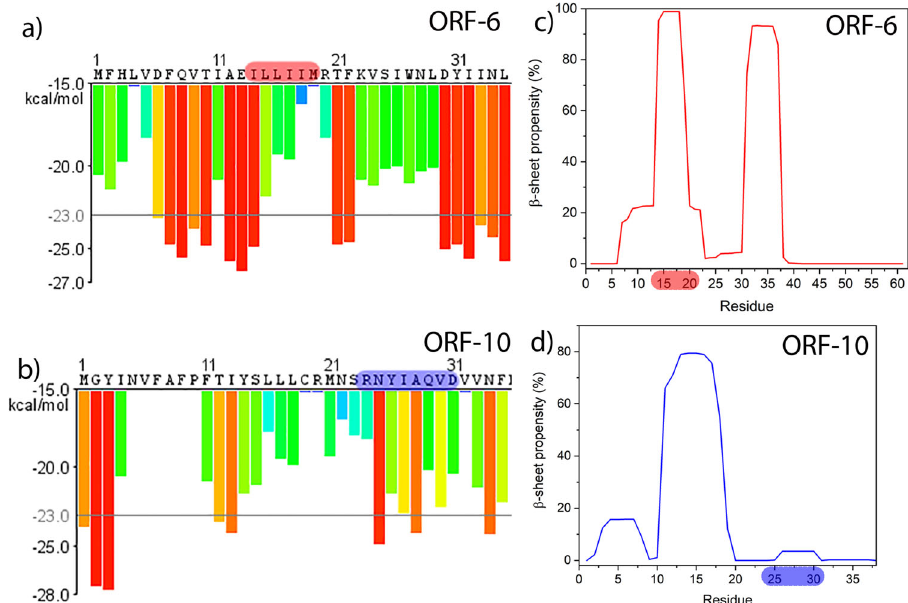
Fig. 1 Output from amyloid assembly prediction software for SARS-CoV-2 ORF6 and ORF10 sequences. a , b Outputs from amyloid predicting algorithm ZIPPER identifying hexapeptide fragments predicted to form steric zippers nucleating the assembly of amyloid fi brils. Hexapeptides with Rosetta energies below − 23 kcal mol − 1 are predicted to be highly amyloidogenic and are shown with red bars. c , d Outputs from amyloid predicting algorithm TANGO indicating sequence regions of high propensity to form β